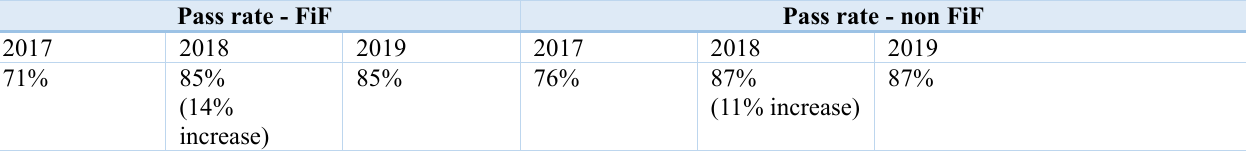
Comparison of Pass Rates Between FiF and Non FiF Students Pass rate - FiF Pass rate - non